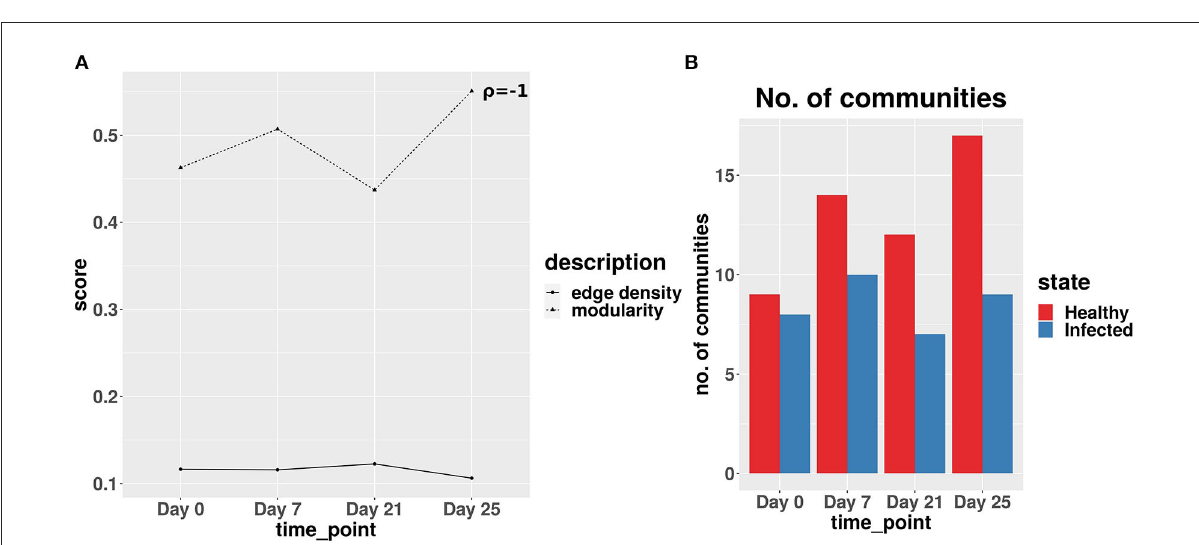
FIGURE8 (A) Average edge density and modularity scores of the co-abundance networks for infected cohort. ρ denotes the Spearman correlation coefficient between average edge density and modularity scores across all time-points. (B) Number of communities obtained for real-life